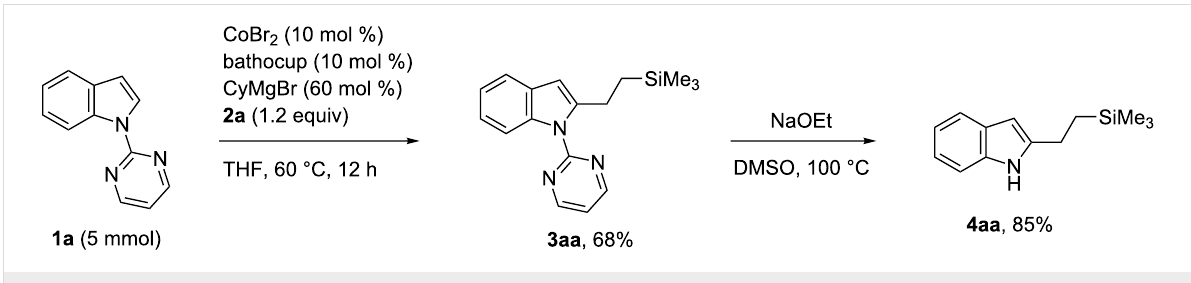
Scheme 4: Gram-scale reaction and deprotection of N -pyrimidyl group.